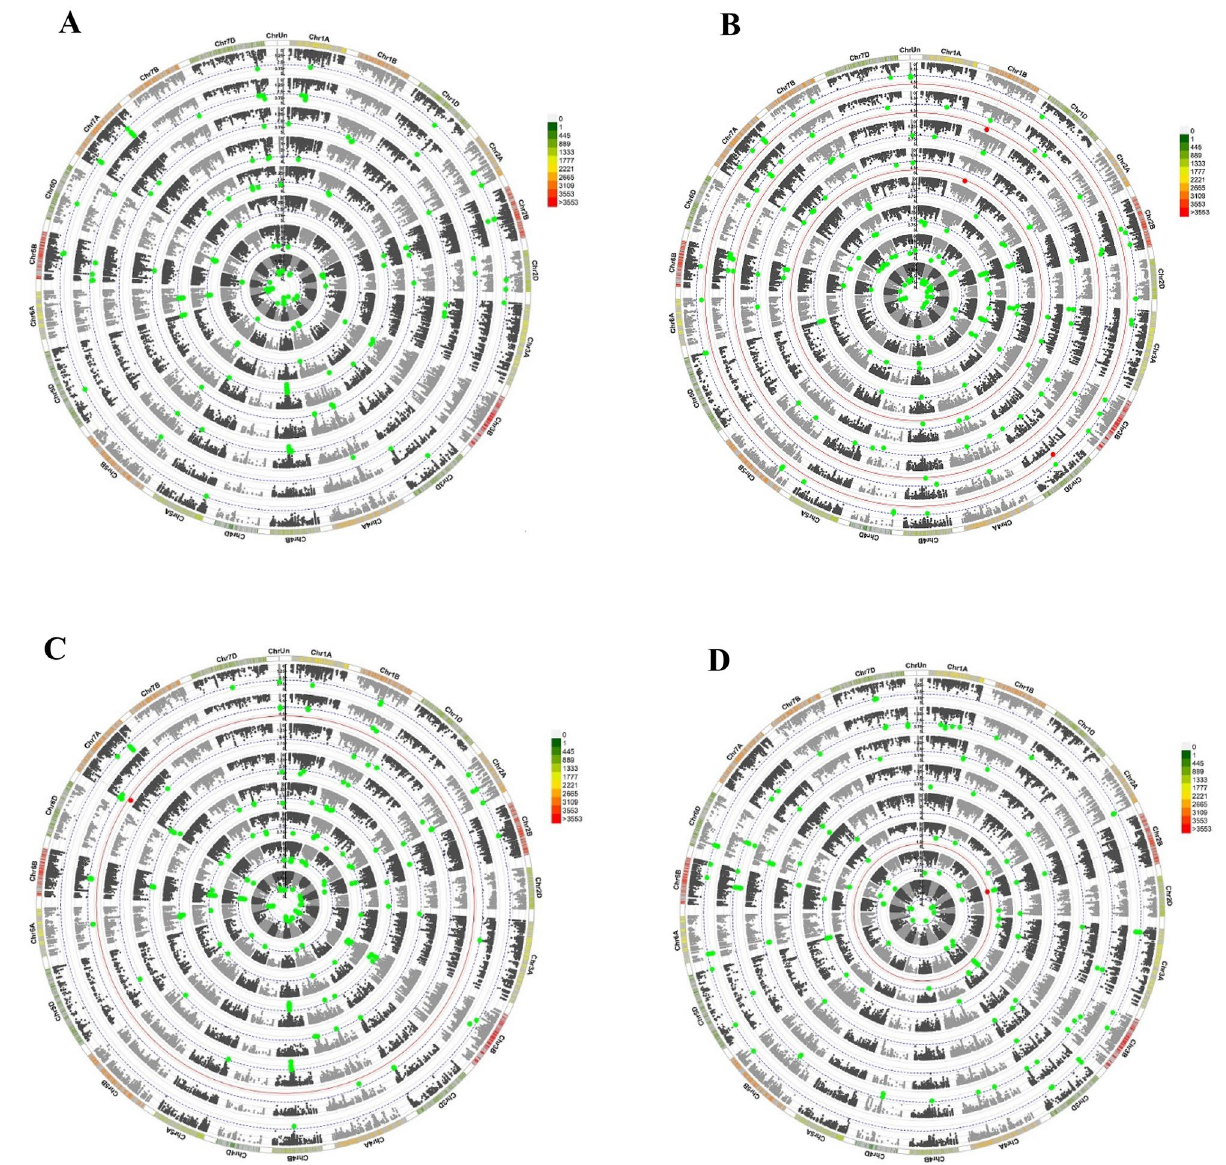
Figure 6. Circular Manhattan plots to draw common regions associated with grain yield ( A ), number of grains ( B ), spike weight ( C ), and plant height ( D ) in Iranian wheat landraces and cultivars. Inner to outer circles represents average trait and stability indices including ASV, bi, HMRPGV, MASI WAASBY, Wi, and YSI, respectively. The chromosomes are plotted at the outmost circle where thin dotted blue and red lines indicate significant level at p value < 0.001 (− log 10 ( p ) > 3) and < 0.00001 (− log 10 ( p ) > 5), respectively. Green and red dots indicate genome-wide significantly associated SNPs at p value < 0.001 and < 0.00001 probability level, respectively. Scale between ChrUn and Chr1A indicates − log 10 ( p ) values. Colored boxes outside on the top right side indicate SNP density across the genome where green to red indicates less dense to